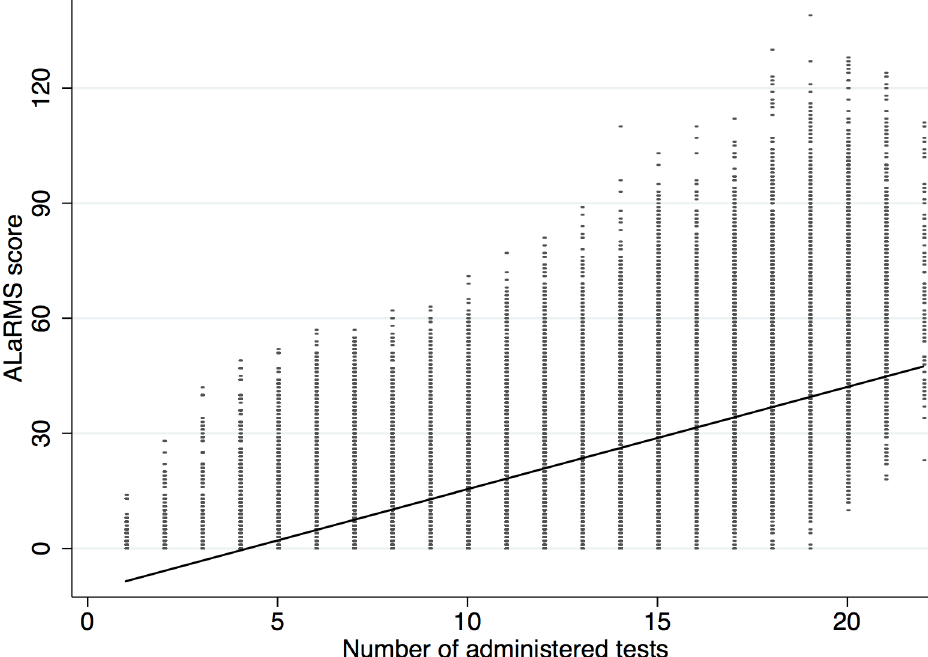
Fig 1. Linear trend of ALaRMS score vs. number of administered tests ordered by the physician in charge.